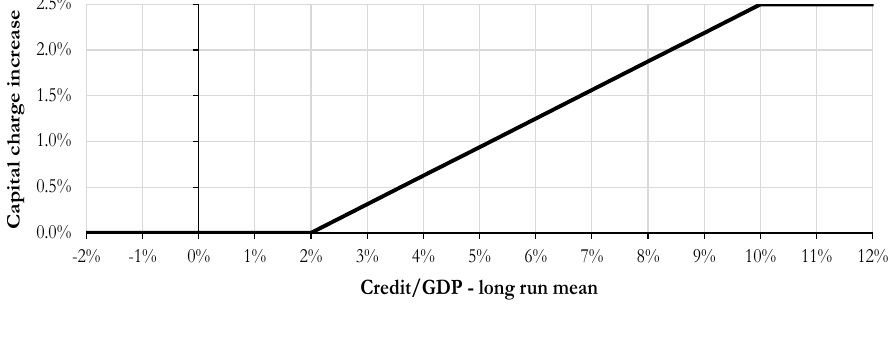
Credit/GDP - long run